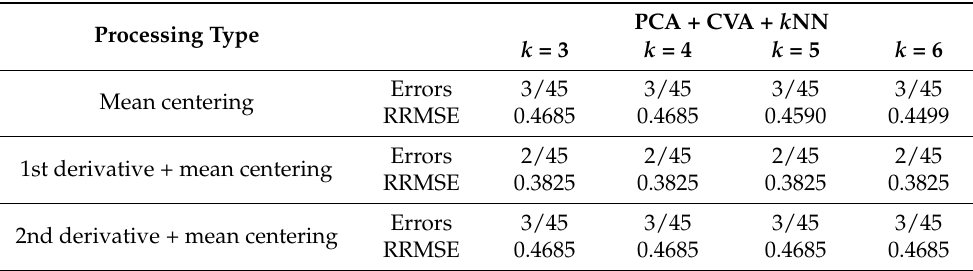
Table 12. Study No. 3 with Combined NIR + MIR Spectral Data. Prediction-Set Classification Errors (45